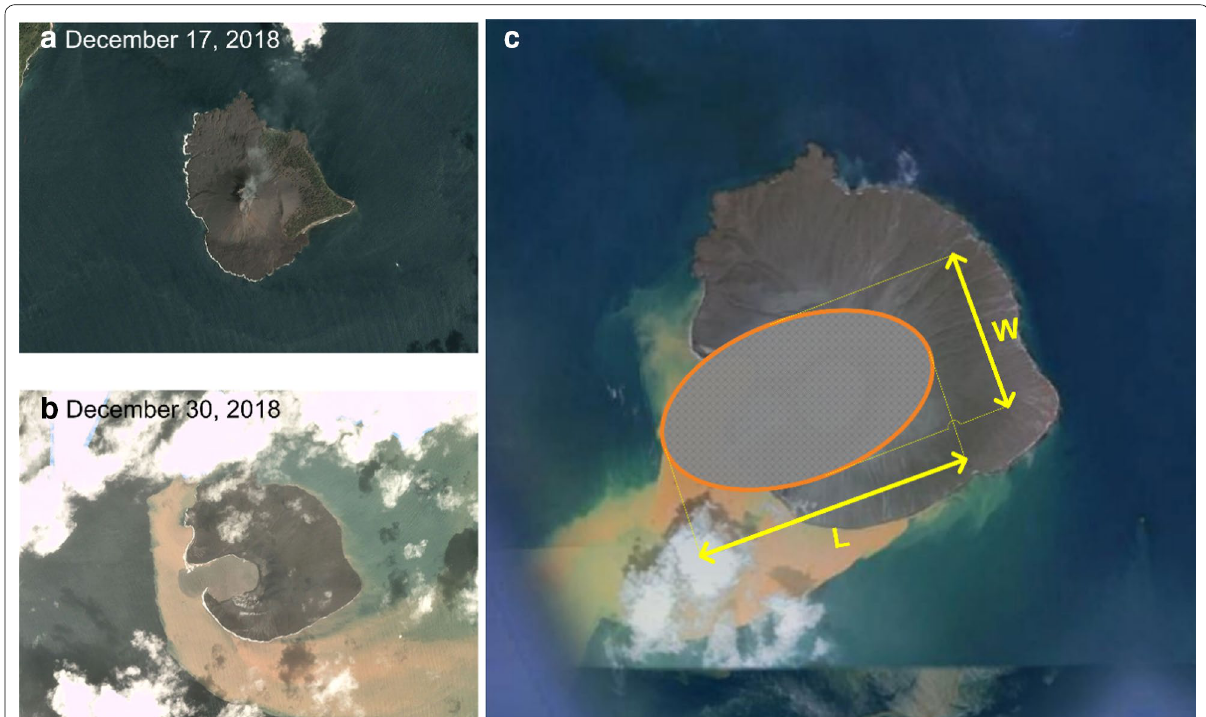
Fig. 2 Landslide modeling for the 2018 Anak Krakatau eruption: a satellite image before the event, b satellite image after the event, and c landslide model based on the ellipsoid shape. source: Google